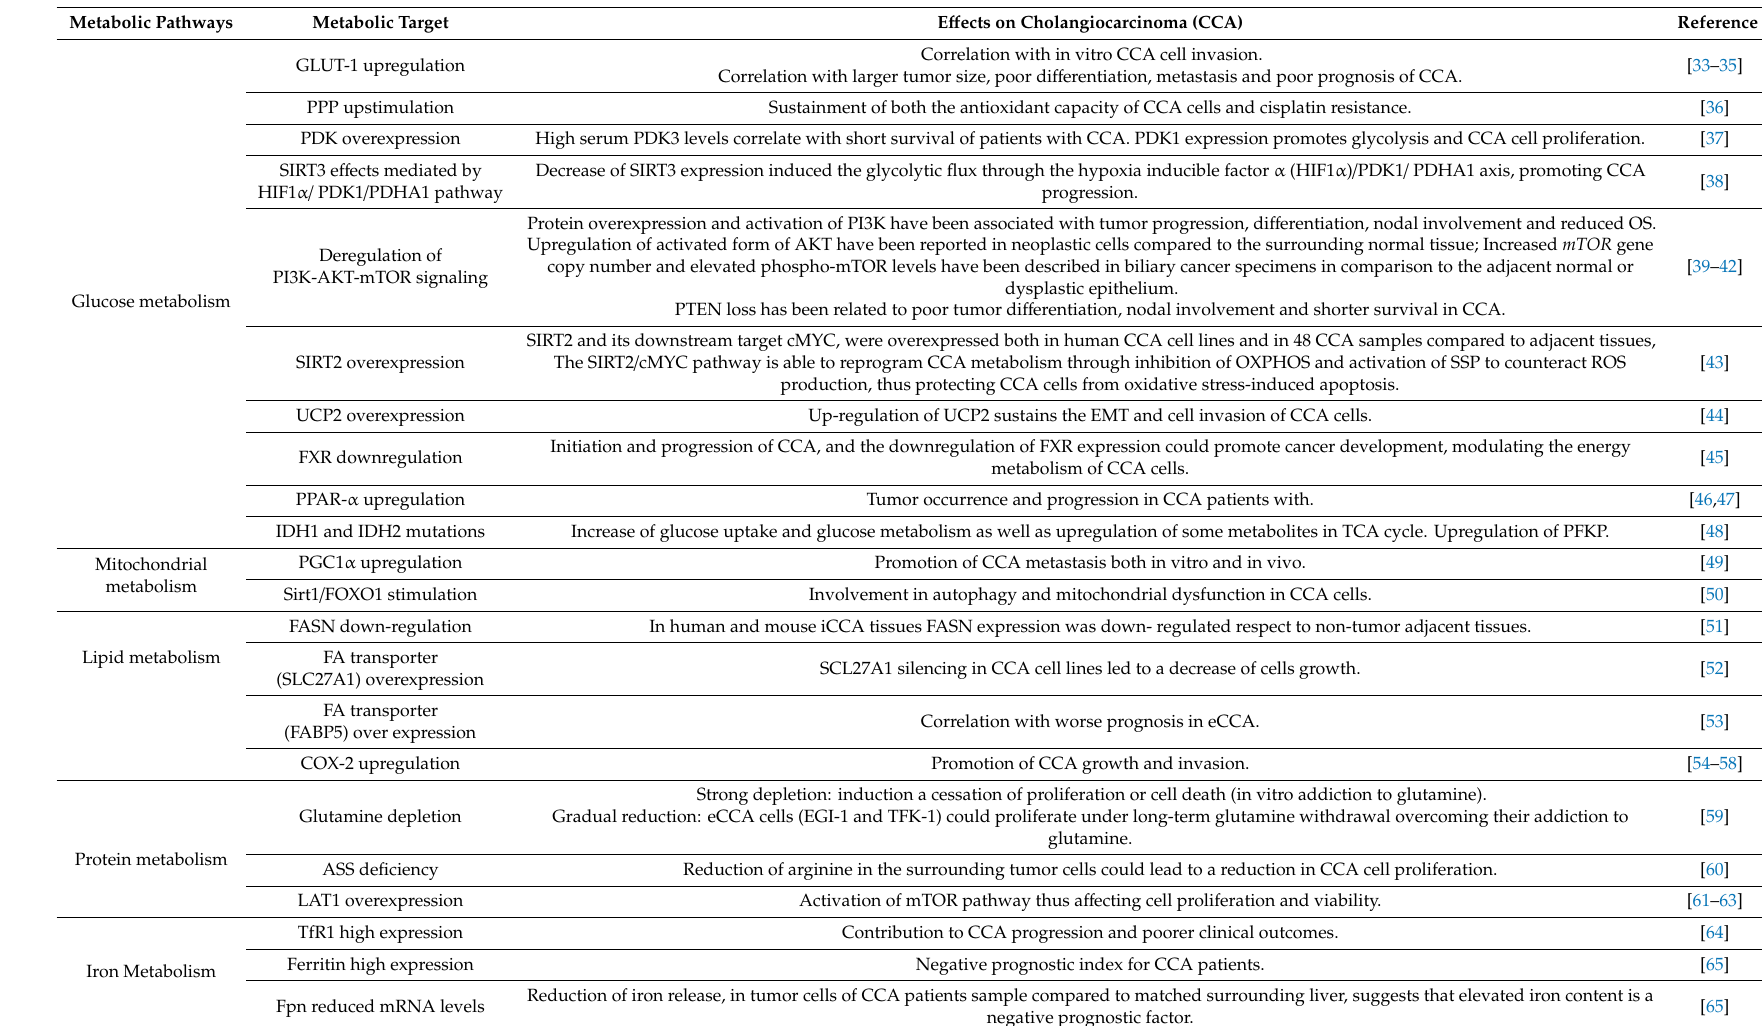
Table 1. Major altered metabolism pathways in